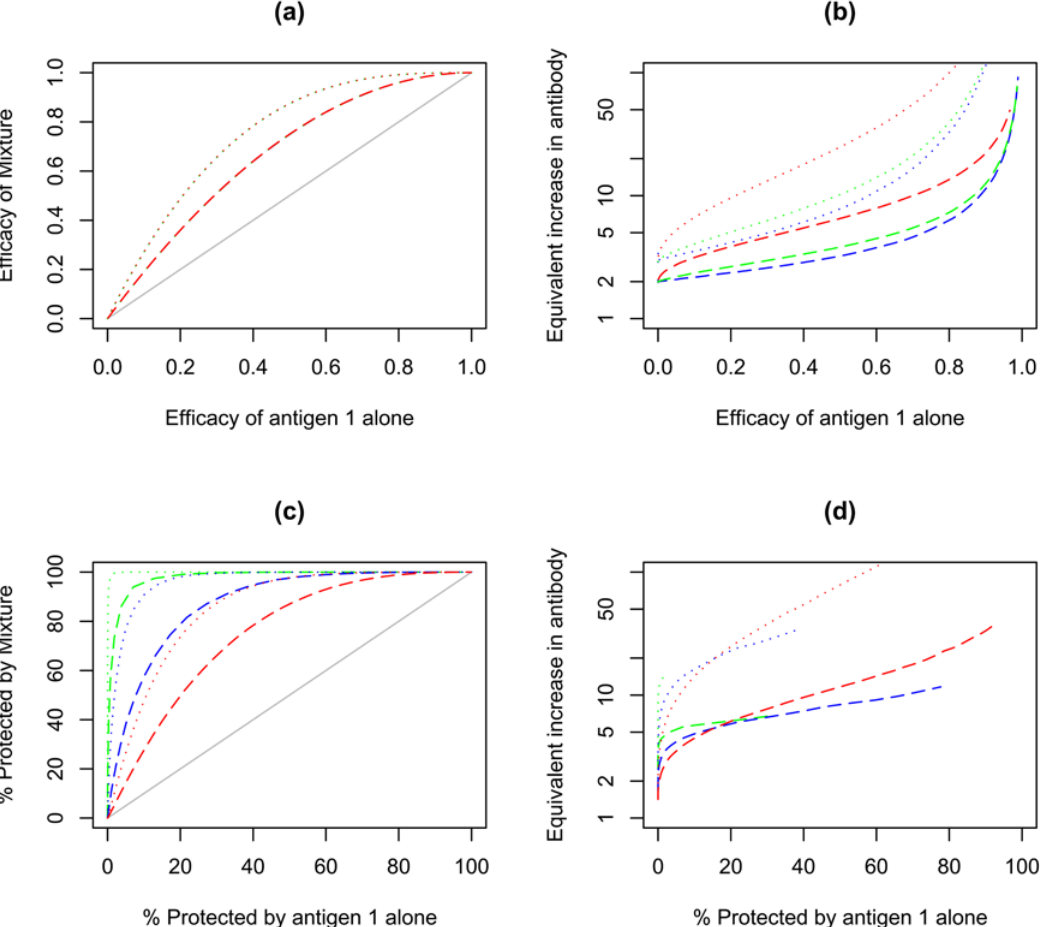
Figure 3. Effect of the diversity of immune response on efficacy and percentage of the population protected by two component (dashed lines) and three component vaccines (dotted lines) for vaccines using the same model parameters as Fig. 2 where each component has the same average immunogenicity. (a) The efficacy of a two or three component (grey solid line) as a function of the average efficacy of single component vaccines. Diversity of the immune response has no impact on the efficacy of the mixed vaccine so the curves for the three component vaccines (dotted upper lines) coincide as do the curves for the two component vaccines (dashed middle line). (b) Relative immunogenicity that would be needed with a single component vaccine to match the efficacy of a two or three component vaccine as a function of the average efficacy of single component vaccines. The relative immunogenicity is the ratio of the immune response required in a single component vaccine to the immune response of the best immunogen in a multi-component vaccine with similar efficacy (c) Comparison of the percentage of the population protected (relative risk of 0.1 or less) of a two or three component vaccine to the percentage protected with a single component vaccine (grey solid line) as a function of the percentage protected with single component vaccines of varying efficacy. (d) Relative immunogenicity that would be required with a single component vaccine to match the percentage protected with a multi-component vaccine as a function of the percentage protected with single component vaccines of varying efficacy. The relative immunogenicity can only be determined over the part of the range where , 100% of the population given a mixed vaccine is protected.